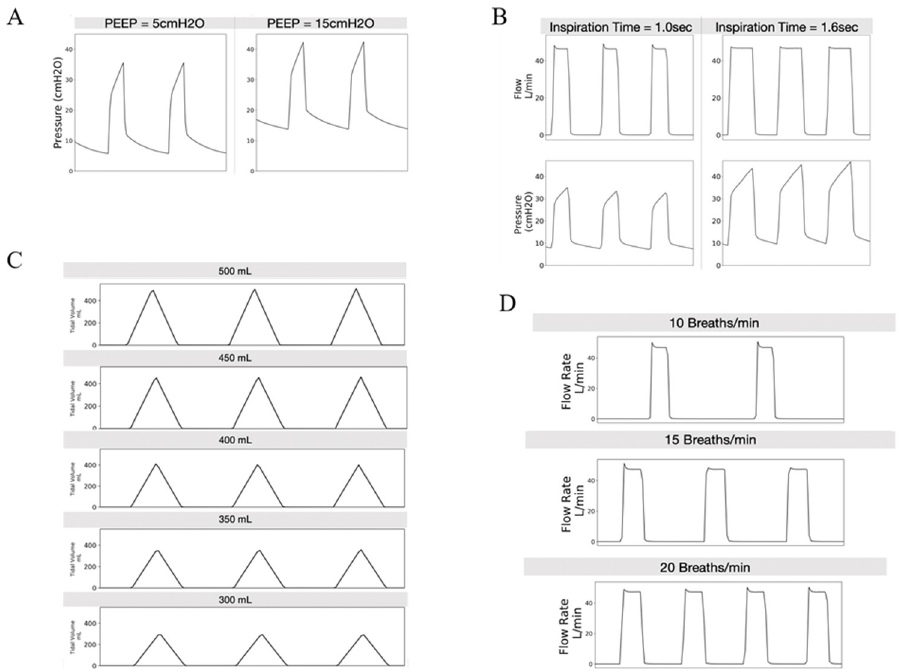
Fig 2. Bench test results of the O2U ventilator. (A) Positive end-expiratory pressure (PEEP) as a function of time as measured on the benchtop test setup for the O2U ventilator (left) PEEP at 5 cmH 2 O and (right) 15 cmH2O set via an external diaphragm valve on the O2U ventilator, x-axis is time. (B) Inspiration time is the duration of time that the gas is delivered to the patient. This is important to be able to vary to manage different lung care strategies and ventilation parameters. Shown here is the difference between 1.0 s and 1.6 s on the dynamic effects on the flow and PEEP pressure signals, x-axis is time. (C) Tidal volume, or the volume delivered to the patient is a critical variable in patient care to ensure adequate oxygenation while not over pressurizing the lungs. The O2U ventilator is capable of providing greater than the FDA-required range to manage the majority of COVID-19 patients. This range is shown in 50 mL increments from 300 mL to 500 mL, x-axis is time. (D) Breath rate (and inspiratory time) controls the minute volume of gas (L/ min) supplied to the patient. Control of the breath rate is essential for patient care as this varies based on patient age and underlying conditions and can often change during ventilation. These graphs show 10 (top), 15 (mid), and 20 (bottom) breaths per minute as set by the UI of the O2U ventilator for a flow rate of 50 L/min, x-axis is